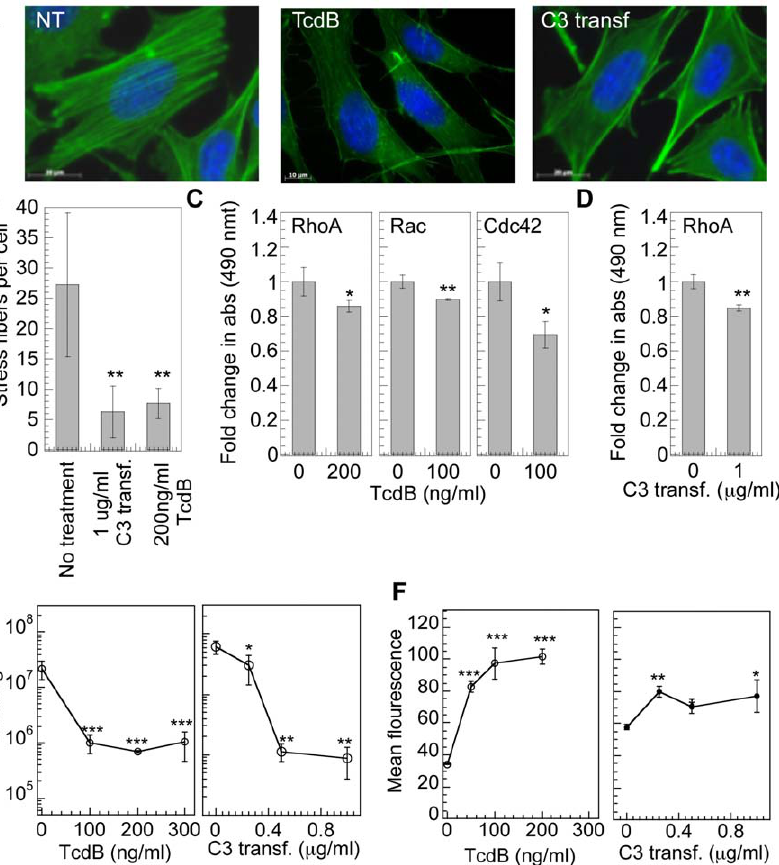
Figure 2. RhoGTPase inhibition using TcdB and C3 transferase decreases transgene expression. mMSCs were plated on fibronectin (40 m g/mL) coated tissue culture plastic for 16 hours prior to being treated with 0–300 ng/ml TcdB for 4 hours in serum free media, or 0–1 m g/ml C3 transferase for 4 hours. ( A ) Cell morphology was studied immediately after treatment with inhibitor, by staining cells for actin using Alexa488 (green) conjugated phalloidin, and for DNA using Hoechst 33258 dye (blue). Images were taken with a Zeiss AxioObserver Z1 inverted microscope at 100 6 magnification. ( B ) Stress fiber quantification. Statistical analysis was done using a one-way Anova followed by the Dunnett Multiple Comparison test. The Anova p value was 0.0052. The symbol ** represents a significant change in stress fibers with respect to untreated cells to the level of p , 0.01. ( C ) Active RhoGTPase quantification was performed using GLISA specific for RhoA, Rac1,2,3 and Cdc42. ( D ) Active RhoA quantification was performed using GLISA specific for RhoA. Statistical analysis was done using the unpaired t-test (two tail p value) where active RhoGTPase level in treated cells was compared with untreated cells. The symbols * and ** represents a significant change to the level of p , 0.05 and p , 0.01, respectively. ( E ) Cells were transfected immediately post treatment and transgene expression was analyzed at 48 hours using luciferase assay and normalized with total protein quantified using Peirce BCA assay. ( F ) Cells were transfected immediately post treatment with YOYO-1 labeled polyplexes and after 2 hours cells were collected with trypsin and polyplex internalization analyzed by flow cytometry. A total of 7000 events were analyzed per